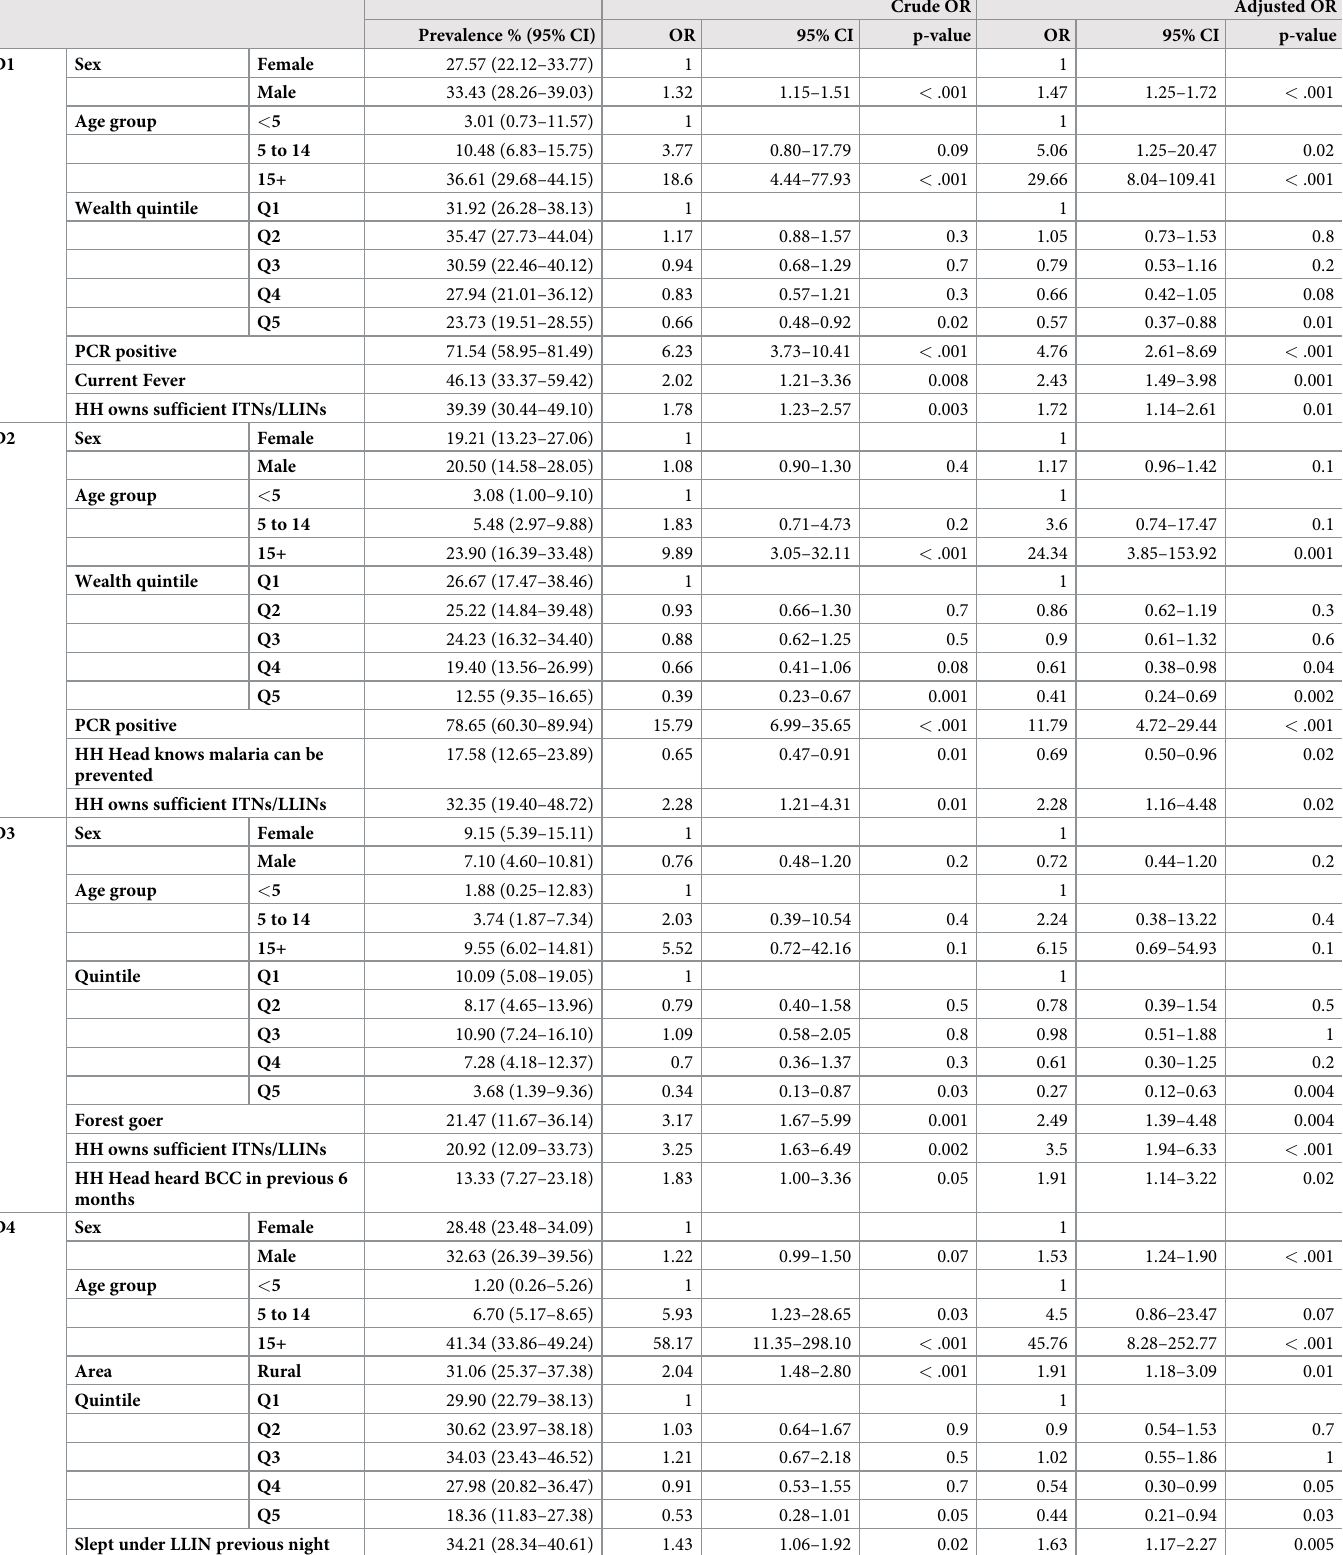
Table 4. Crude and adjusted odds ratios for P . falciparum seropositivity per